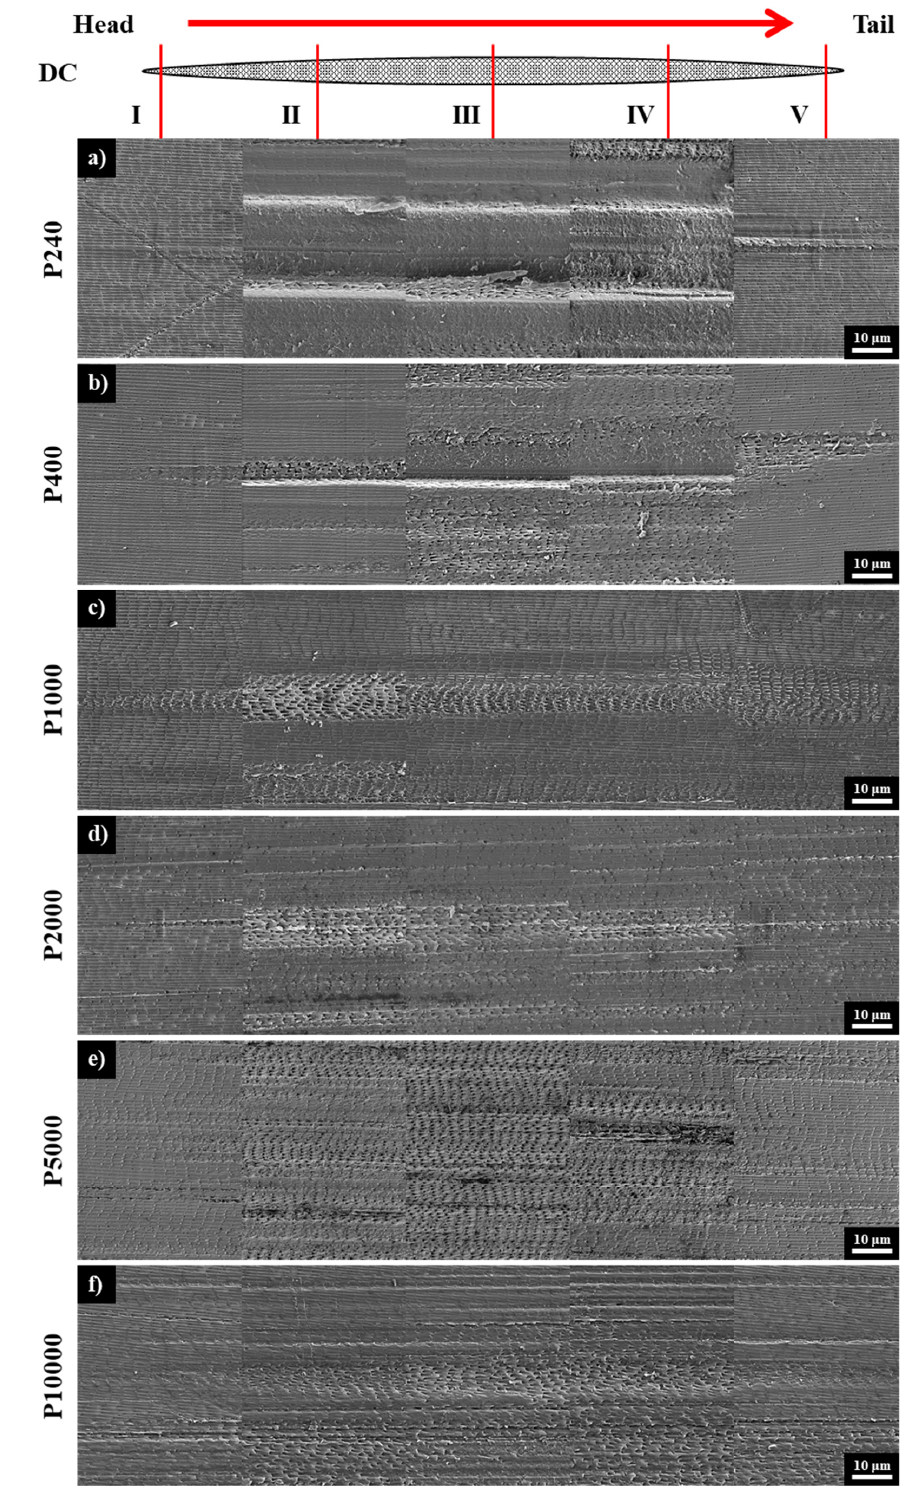
Figure 6. Comparison of wear scar in DC between ( a ) P240, ( b ) P400, ( c ) P1000, ( d ) P2000, ( e ) P5000, and ( f ) P10000 (5 kV, 5000×). The red arrow indicates the scratch direction.